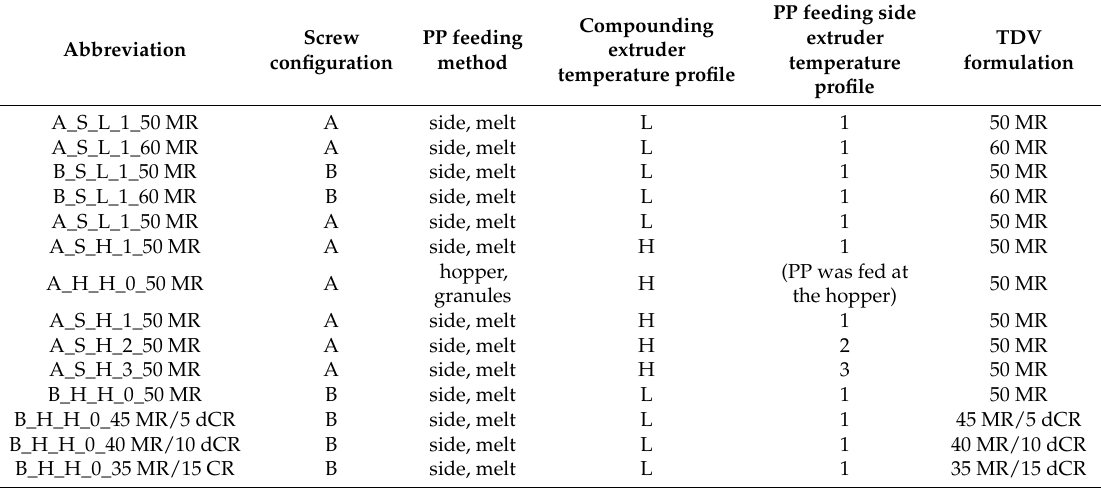
Table 6. Abbreviations used for the TDV samples having different compositions and produced with various processing